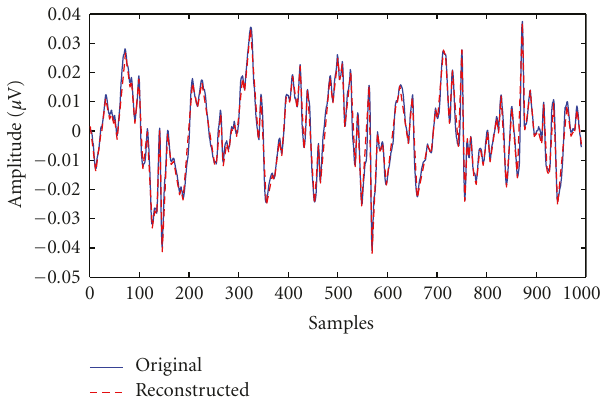
Figure 14: A zoom-in view of the comparison of original and reconstructed EEGs in Figure